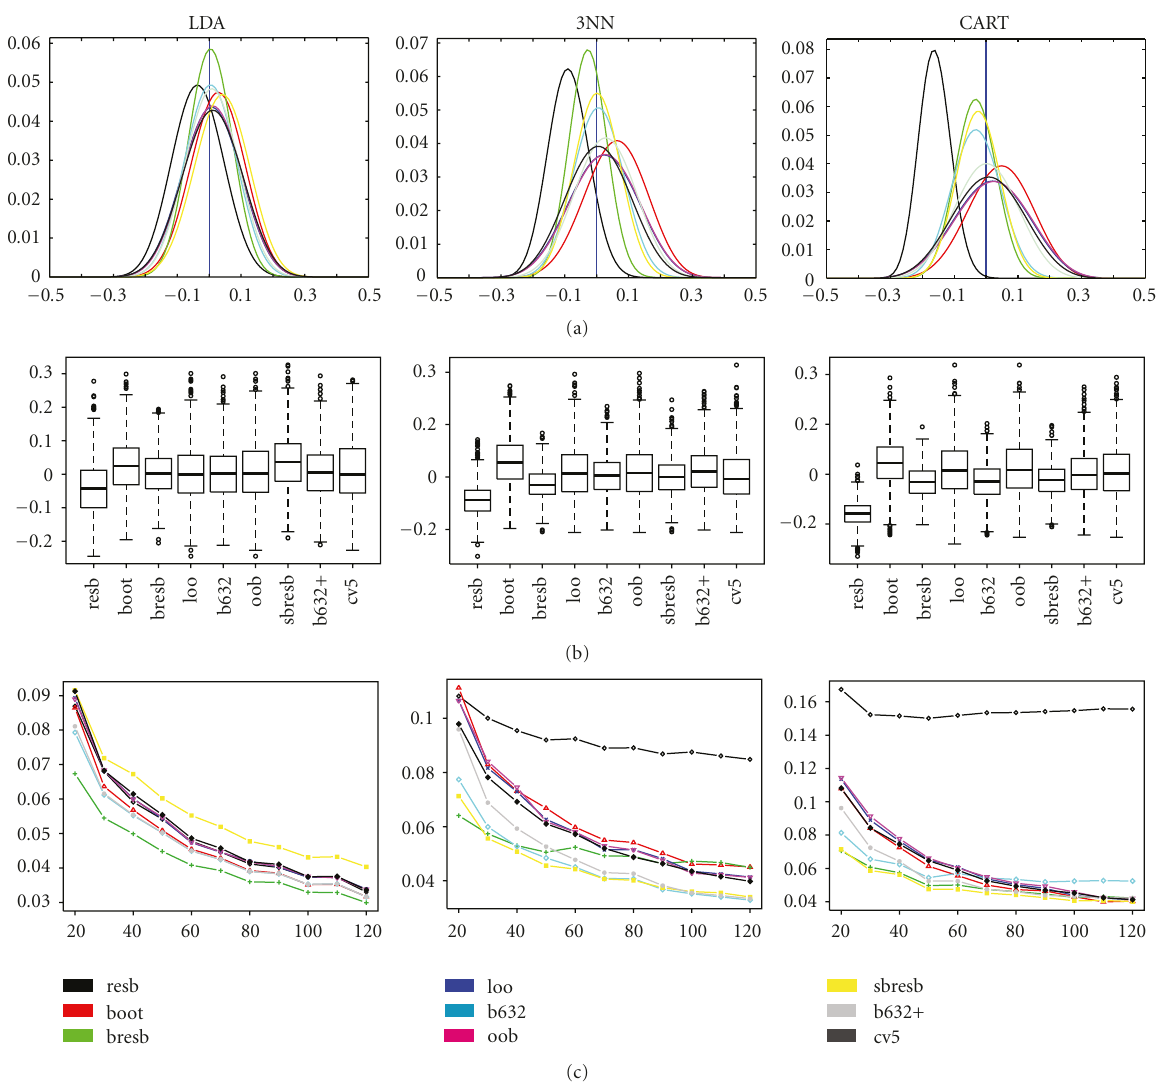
Figure 4: Empirical deviation distribution (a), box plots (b), and RMS as a function of sample size (c), for synthetic Gaussian model with Bayes error = 0 . 15, sample size n = 20, and dimensionality p = 2, with di ff erent base classification